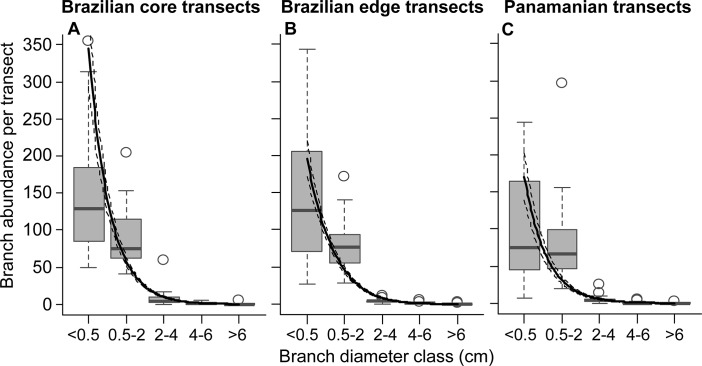
Branch abundances as a function of branch diameter.A) Brazilian core transects (n = 30). B) Brazilian edge transects (n = 30). C) Panamanian transects (n = 36). Box-plots show the median as central line, the first and third quantiles as the bottom and top box limits, 1.5 interquantile range as whiskers, and outliers as circles. Solid lines show fits from GAMMs with 95% CI indicated by dashed lines.